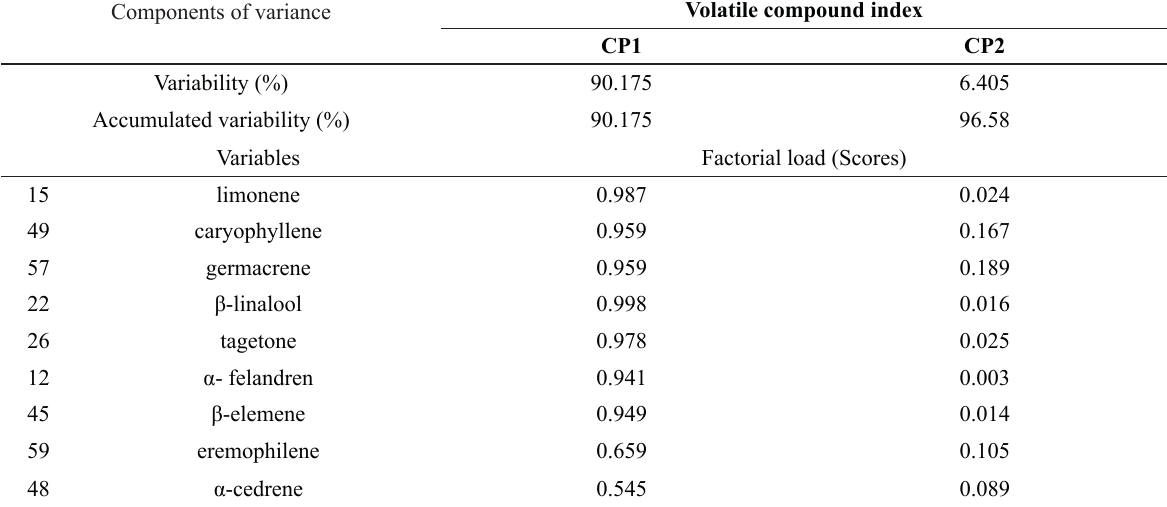
Chemical attributes of volatiles of Lippia rotundifolia with the eigenvalues of the main components from the eleven naturally occurring populations in Minas Gerais,